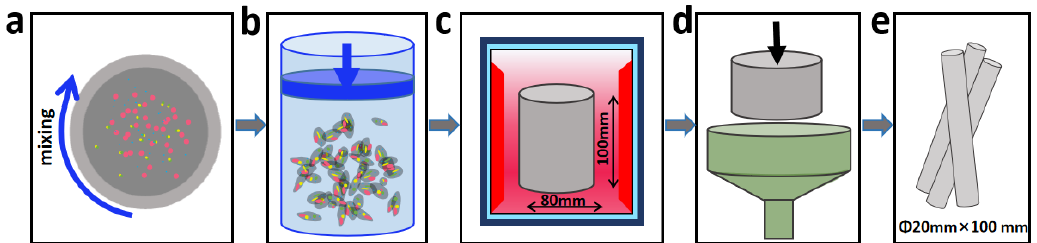
Figure 1. Schematic diagram of composite preparation process: ( a ) mixing the powders; ( b ) pressing the powders into an ingot; ( c ) heating the ingot to 800 °C; ( d ) extruding the heated ingot; ( e ) the achieved rods after extrusion.